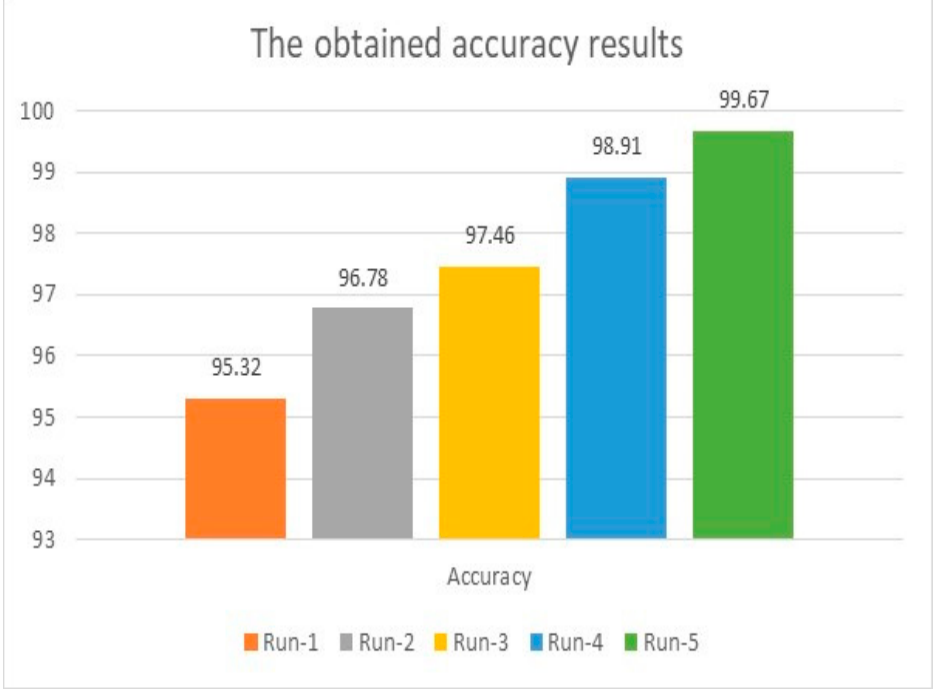
Figure 3. Accuracy analysis using the integration of AlexNet and ResNet50V2.